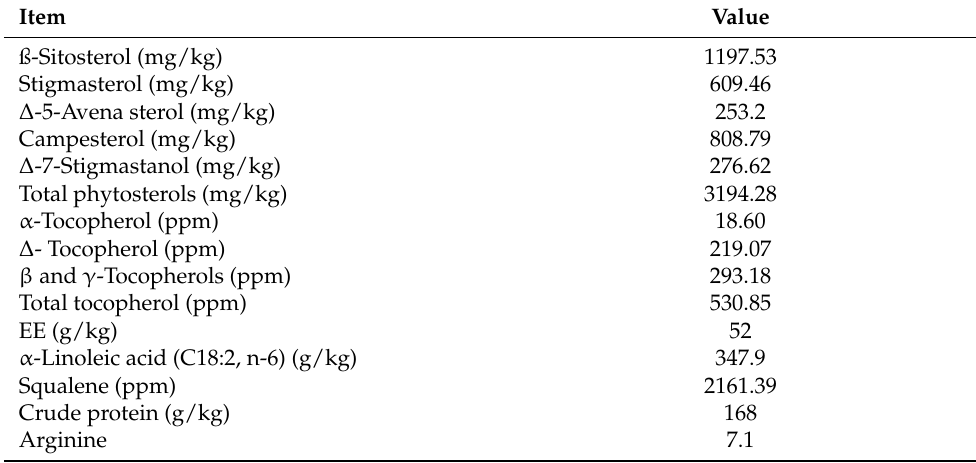
Table 2. Bioactive phytochemical compound content and amino acid profile of amaranth grain ( Amaranthus hybridus chlorostachys